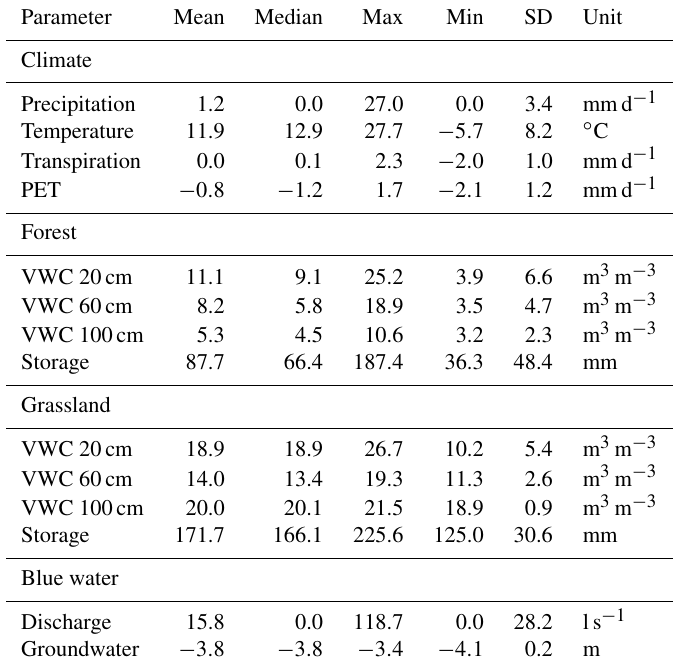
Table 3. Summary statistics for the daily time series shown in Fig.